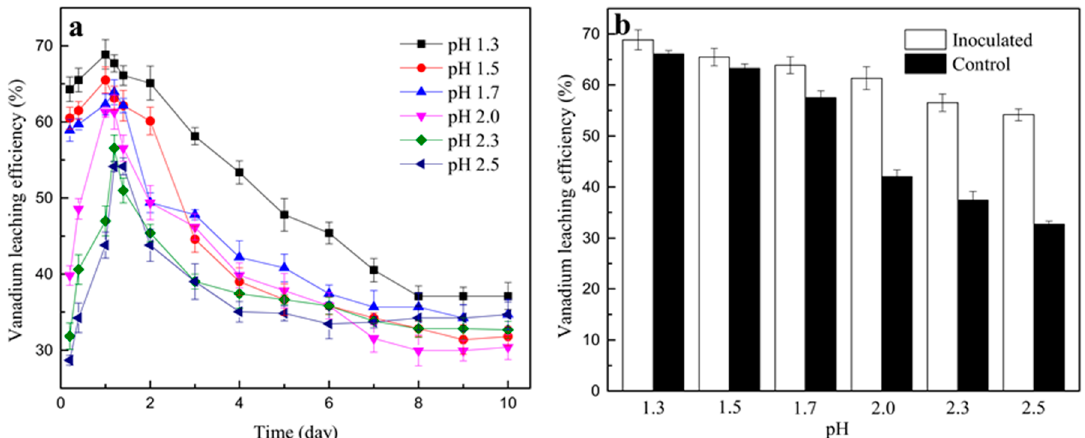
Figure 3. Vanadium leaching efficiency ( a ) and the highest vanadium leaching efficiency of the inoculated tests and that of the control tests ( b ) at different pH.